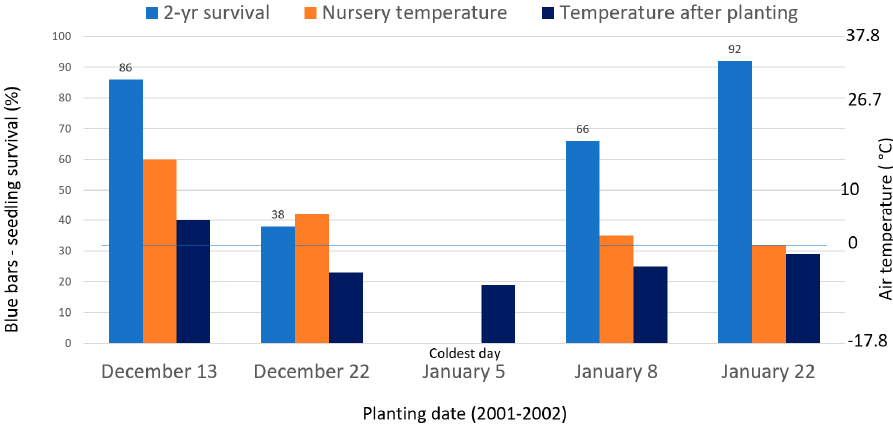
Figure 16. The effect of planting date on survival of container-grown longleaf pine seedlings stored for 10 weeks in a nursery cooler at +1.7 °C. Data from [118]. Seedlings were packed in boxes and placed into storage on 2, 16, 30 October and 13 November 2001. The lowest temperature at the nursery (for the lifting date) is represented by orange bars while black bars represent low tempera- tures recorded at Lumberton, North Carolina, a few days after planting. Accumulated natural chilling hours (0 to 7.2 °C) for Goldsboro, NC was 125 h for 13 November 2019. A temperature of − 7.2 °C on January 5 likely contributed to the mortality of seedlings planted two weeks earlier.